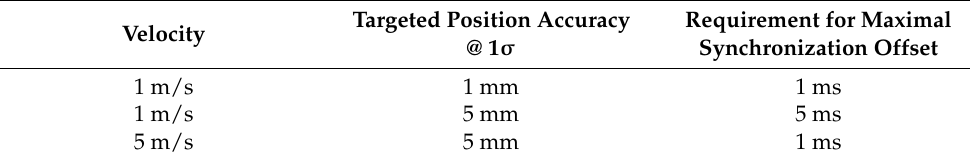
Table 2. Relationships between velocity, synchronization, and